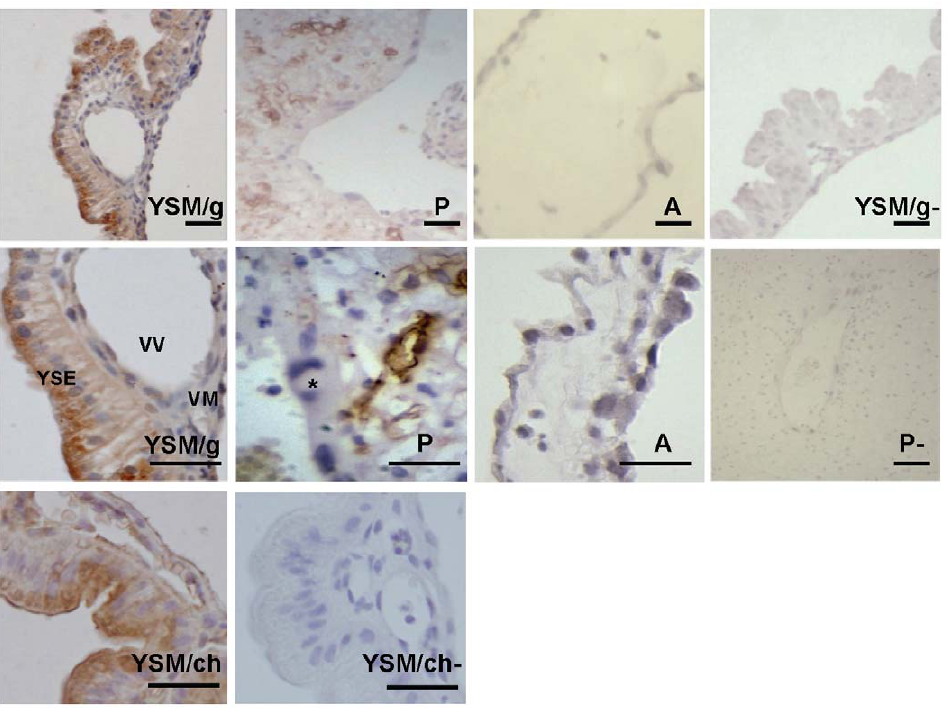
Figure 5. FcRn expression was evaluated in tissue sections from rabbit yolk sac, amnion and placenta from 23 dpc fetuses. For immunohistochemical staining we used a commercially available goat polyclonal mouse FcRn a -chain specific antibody (/g) which cross-reacts with rat, human and bovine FcRn. In the yolk sac membrane (YSM), we also used the chicken FcRn a -chain specific antibody (/ch) which we generated and validated to be rabbit FcRn a -chain specific. We detected strong FcRn specific staining in the apical plasma membrane of the brush border, in the apical region and in vesicles that transverse the endoderm cells (YSE), in the endothelial cells of the vitelline vessels (VV), but not in the vascular mesenchyme (VM) of the rabbit YSM, with the goat and chicken FcRn specific antibodies ( YSM/g and YSM/ch , respectively). In the placenta ( P ), capillary endothelial cells were FcRn a -chain positive, while the trophoblast cells (asterisk) showed no FcRn reactivity. We could not detect the FcRn in the amnion ( A ). (YSM/g-; YSM/ch- and P- represents controls without FcRn a -chain specific antibody; scale bar=25 m m.)